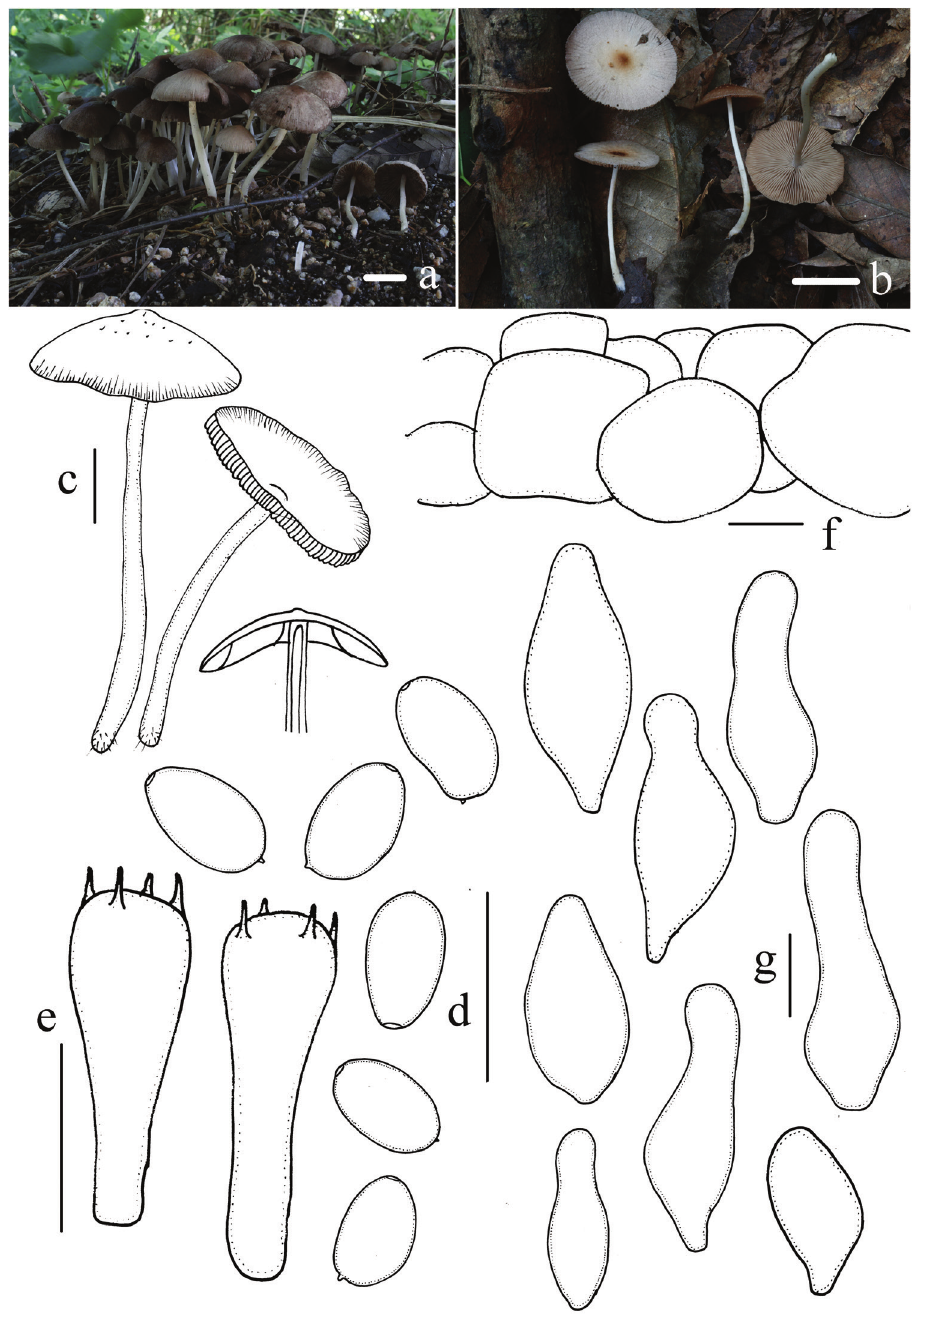
Figure 2. Basidiomata and microscopic features of Candolleomyces subcacao a–c Basidiomata d spores e basidia f pileipellis g cheilocystidia. Scale bars: 10 mm ( a–c ); 10 μm ( d–g